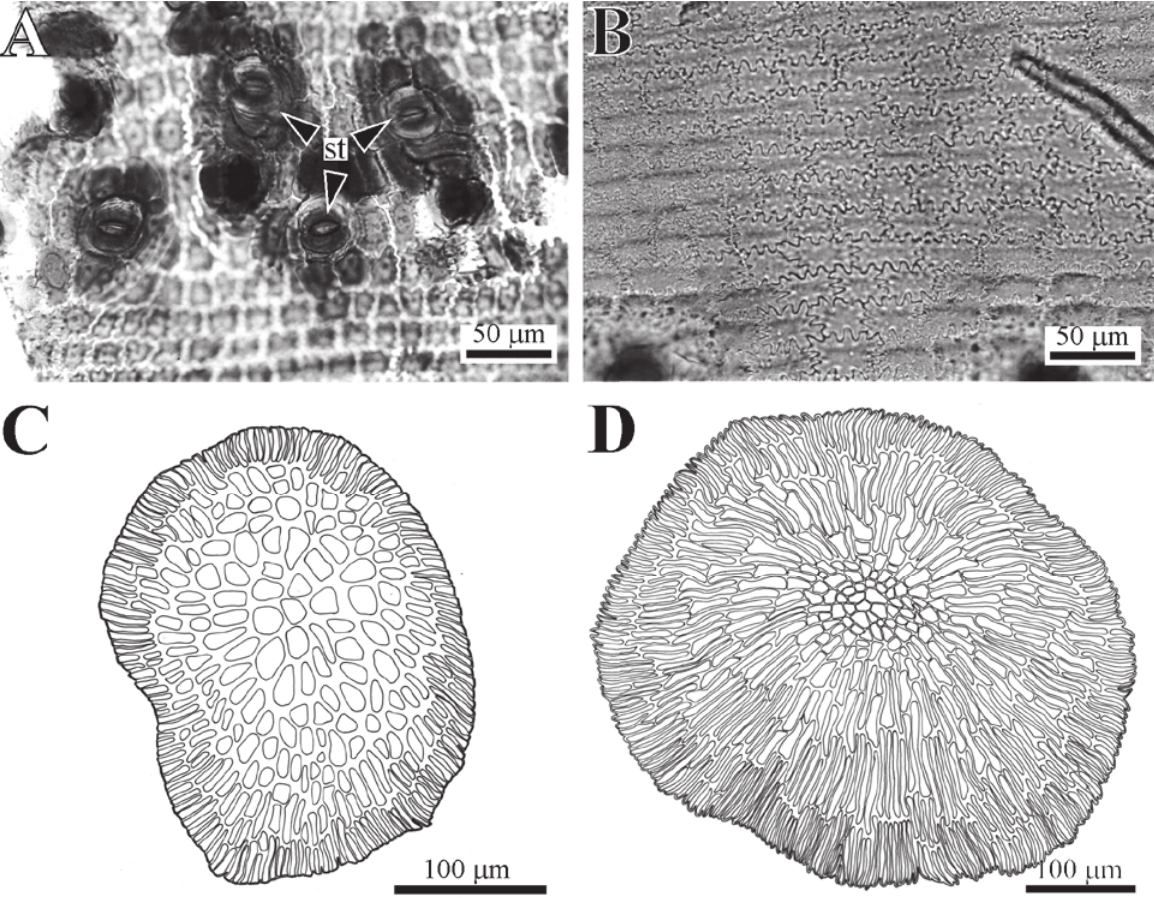
Figure 3 - Epidermis of Neoregelia cruenta in frontal view. (A) abaxial surface of a shade plant plant, (B) adaxial surface of a sun plant, (C) Drawing of a trichome from the middle portion, (D) Drawing of a trichome from the leaf base. st -